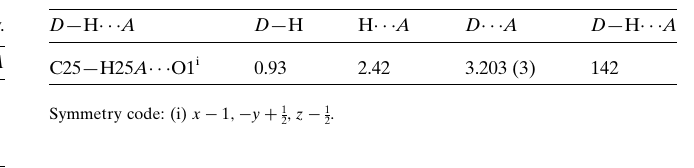
stacked along the bc plane. The weak C10—H10 (cid:3) (cid:3) (cid:3) Cg 1 and C22—H22 (cid:3) (cid:3) (cid:3) Cg 2 interactions also help to establish the